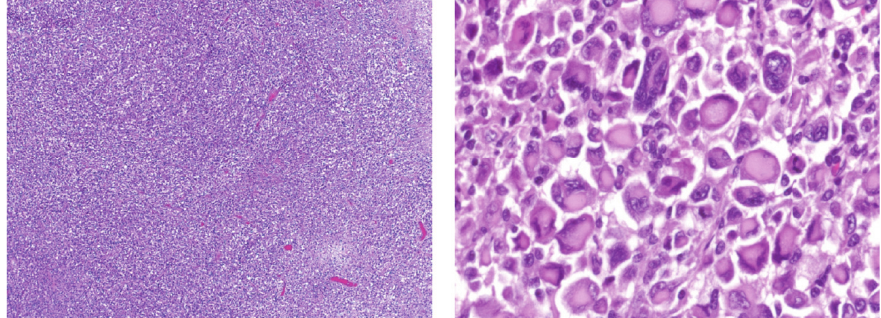
Figure 2: Low and high resolution slides from Temno needle biopsy of the distal femoral lesion showing rhabdoid-appearing cells without the presence of osteoid.